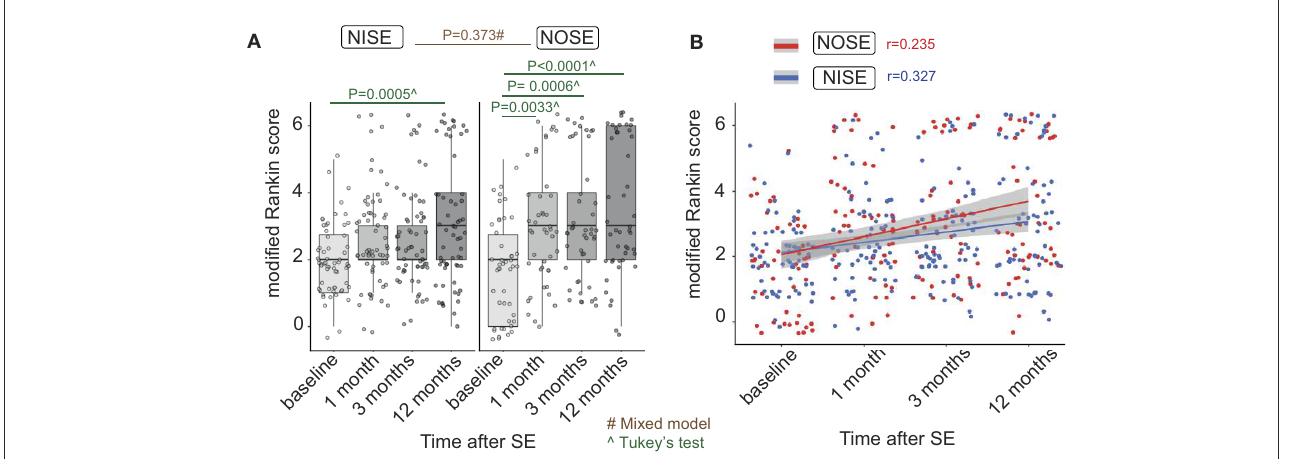
FIGURE2 Outcome assessed by mRS between baseline and 12 months changes in different proportions in NOSE and NISE. (A) Individual mRS at each time point in NOSE and NISE groups. NISE patients had an average mRS of 2.02 at baseline, 2.6 at 1 month, 2.6 at 3 months, and 3.06 at 12 months. In contrast, NOSE patients had an average mRS of 2.02 at baseline, 3.3 at 1 month, 3.47 at 3 months, and 3.78 at 12 months. Therefore, we performed post-hoc analyses on these two groups independently. (B) Correlations between time after SE and outcome (Pearson correlations, r = 0.376 in the PMA group, r = 0.252 in the non-PMA group). Alpha = 0.05/3 =